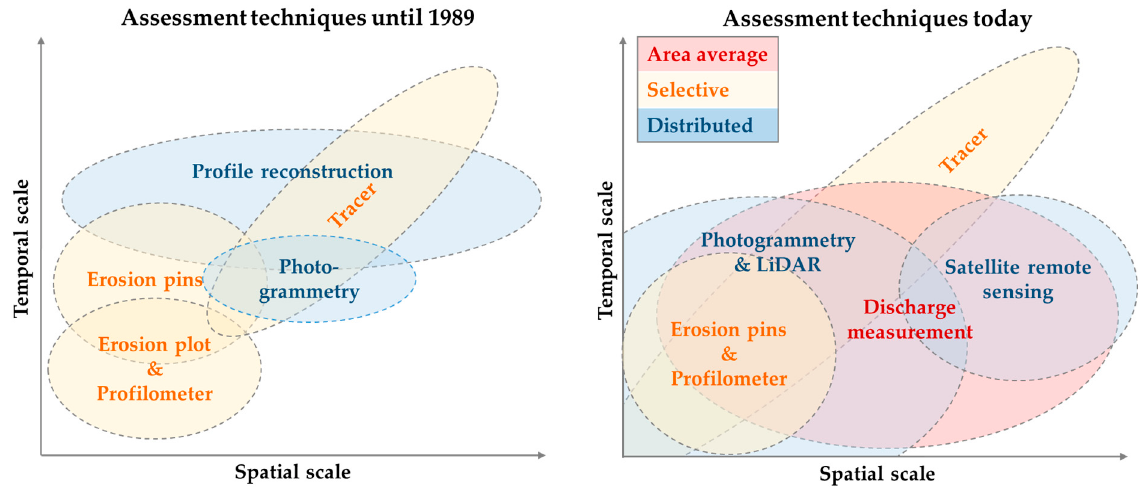
Figure 4. Changes and developments in soil erosion assessment techniques as well as their tem- poral and spatial scales of application, ( left ) derived from Loughran [79] presenting assessment techniques used in 1989 and ( right ) based on information from Guan et al. [75], Li et al. [71], Jester and Klik [76], Thomsen et al. [77], Batista et al. [78], Rodrigo-Comino [74] and, as discussed in Sections 2.2.1 and 2.2.2, methods used up to 2017. The methods are coloured by their type of output (area average, selective or distributed). The category discharge measurement includes aspects such as erosion plots and techniques, also listed in Figure 3 under the heading of sediment collecting.